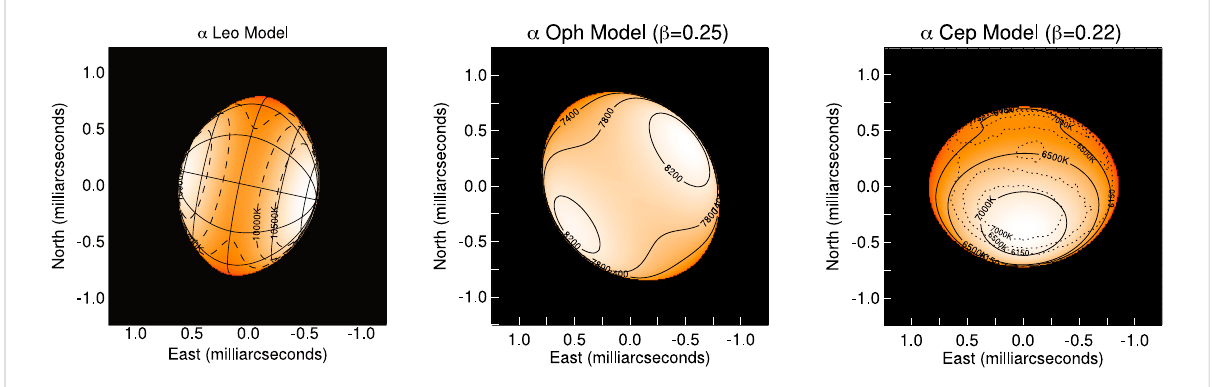
Interferometricobservationsofrapidlyrotatingstars,showingthecentrifugaldistortionandgravitydarkeningphenomena.Lefttoright:Regulus ( α Leo, Che et al., 2011), Rasalhague ( α Oph, Zhao et al., 2009), Alderamin ( α Cep, Zhao et al.,